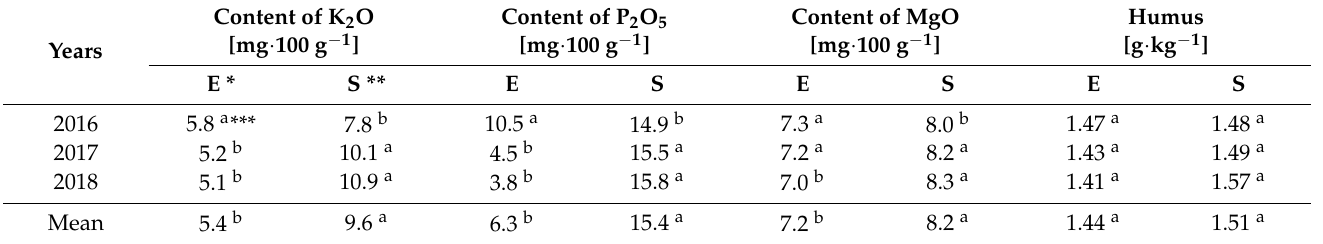
Table 6. The content of available forms of soil potassium, phosphorus, magnesium, and